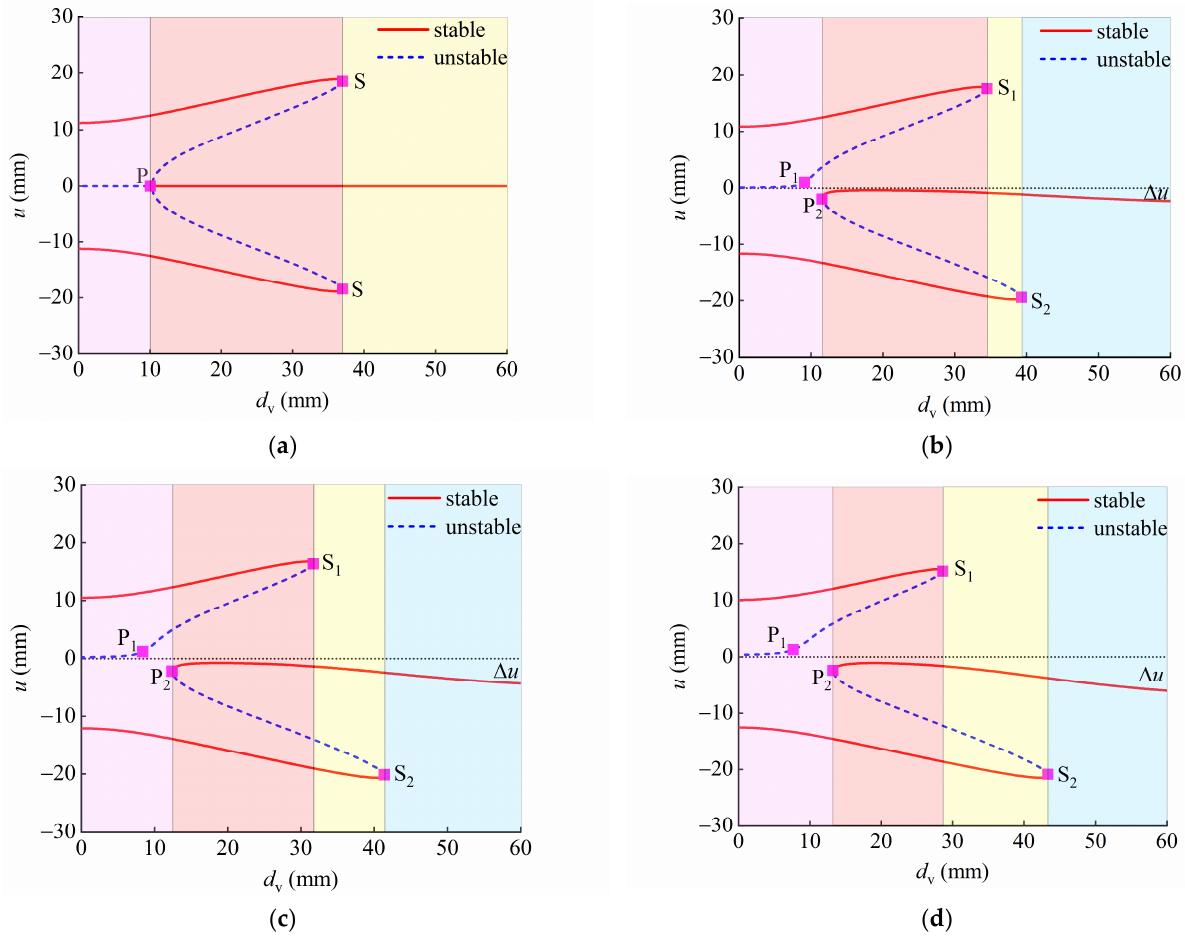
Figure 5. Bifurcation diagram of ( d v , u ) with different end magnet masses M e : ( a ) M e = 0 g; ( b ) M e = 5 g; ( c ) M e = 10 g; ( d ) M e = 15